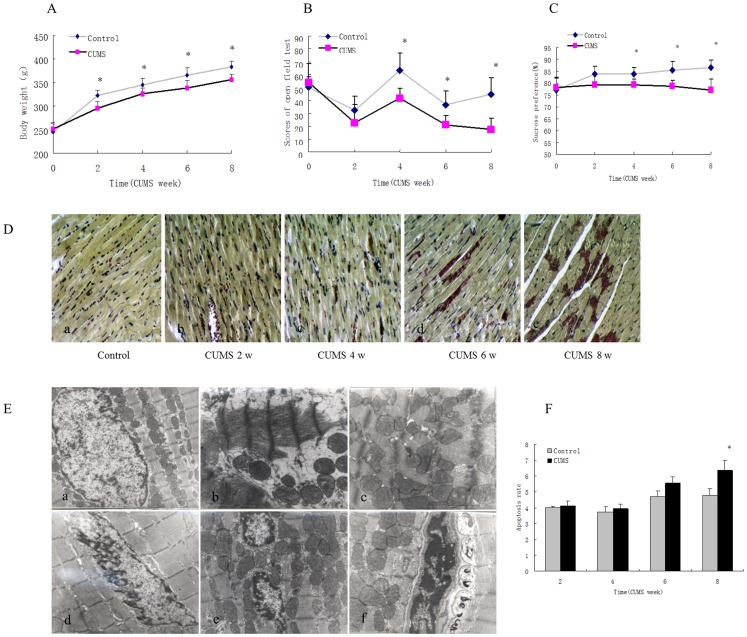
Unpredictable chronic mild stress induces comorbidity of depression-like behavior and myocardial injury in rats.The depression-like behavior and myocardial injury of CUMS rats were measured at 2, 4, 6 and 8 weeks. A. The rats were weighed weekly, and the weights are shown. B. Locomotor activity and exploratory behavior were evaluated as described in the Materials and Methods section. Values are the mean ± SD from 3 independent experiments, *P<0.05 compared with the control. C. A 2-bottle sucrose preference test was used to measure rats’ preferences for sweetened solution over water. Preference was calculated as the percentage of sucrose solution consumed compared to the total fluid intake (sucrose/(sucrose+water) x 100). D. Myocardial damage was observed by Nagar Olsen staining. The size and scale of the red-stained range represent the severity of the injury. There was no injury in control group rats (a) or in 2 and 4 week CUMS rats (b, c). Myocardial injury occurred after 6 weeks of CUMS (d) and increased after 8 weeks of CUMS (e). E. An electron microscope was used to detect pathological ultrastructural alteration. A myocardial ultrastructure showing normal cardiac nuclear, myofibril structure and mitochondria (×10000) in control group rats is shown (a). Abnormal ultrastructural changes such as myofibril breakage were observed after 8 weeks of CUMS (×10000) (b). Mitochondrial disarrangement, mitochondrial interrupted inner membrane and cristae and mitochondrial vacuoles (×10000) are shown (c, f). Nuclear membrane shrinkage and chromatin margination (×10000) were also seen in 8-week CUMS rats (d, e, f). F. Restraint stress increased cardiomyocyte apoptosis as measured by TUNEL. Values represent the group mean ± structural equation modeling (SEM) (n = 8 rats per group). *P<0.05 compared with control, repeated measures ANOVA followed by Tukey’s multiple comparison test.